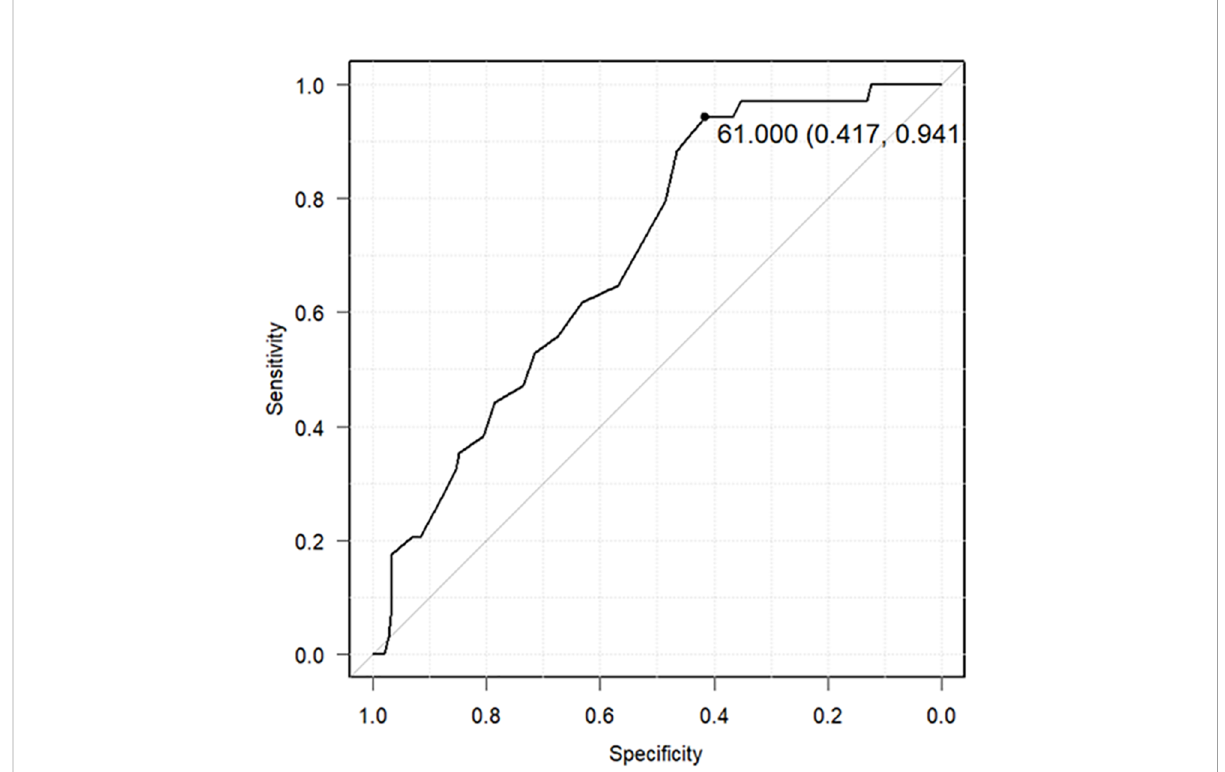
FIGURE 2 Receiver operating characteristic (ROC) curves predicting cancer recurrence using the lowest serum zinc concentrations. The ROC curve predicts cancer recurrence using a cutoff of 61 m g/dL as the lowest serum zinc concentration (sensitivity: 0.417, speci fi city: 0.941, area under the ROC curve: 0.698, 95% con fi dence interval: 0.611 –